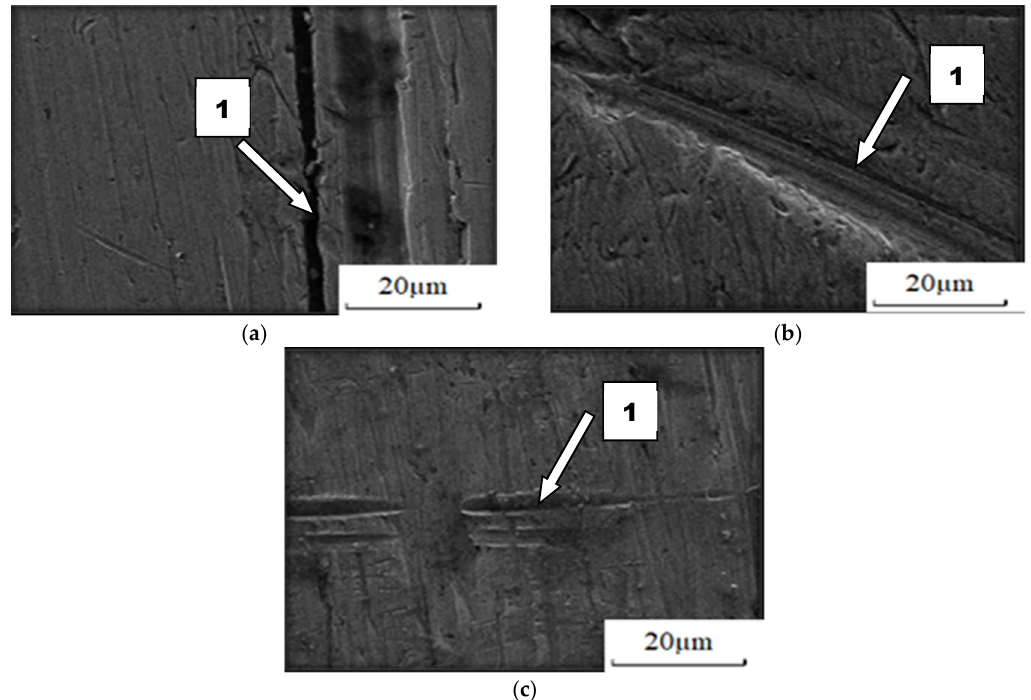
Figure 15. Condition of worn surface of B27 steel in diverse soil conditions: ( a ) light soil, (1) micro-cutting; ( b ) medium soil, (1) furrowing; ( c ) heavy soil, (1) furrowing.